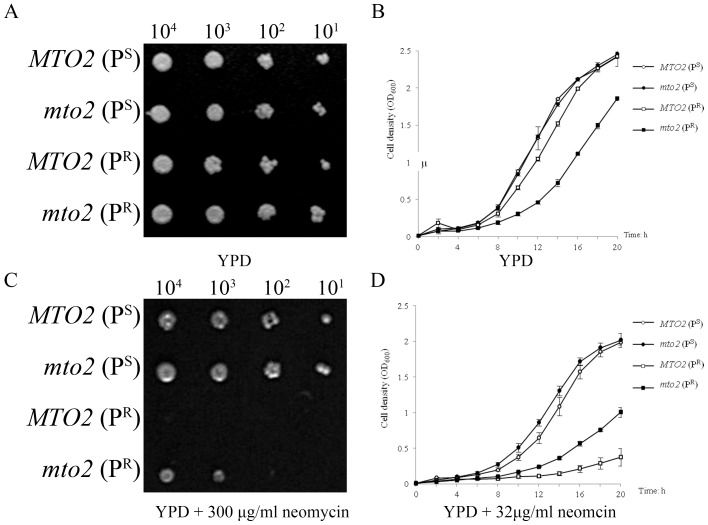
Growth activities of different yeast strains.
A, Series dilutions of each strain were spotted onto a 2% glucose medium (YPD) and the plate was incubated at 30°C for 72 hours. B, Growth curves analysis of yeast strains in the absence of neomycin in 20 hours. C, Growth activities of each strain when grown on medium containing neomycin after 72 hours incubation. D, Growth curves of strains cultured in YPD containing 32 µg/ml neomycin.